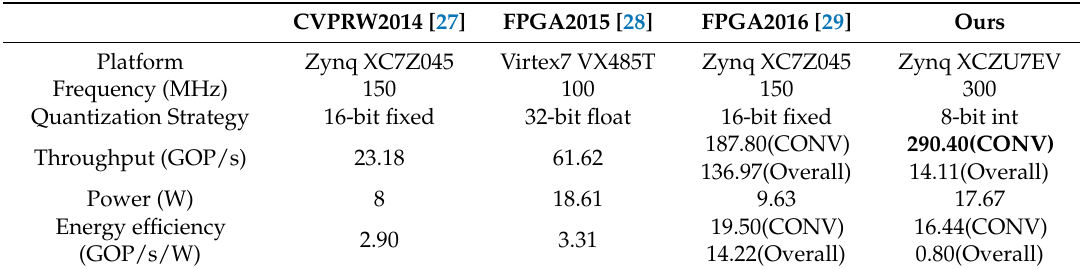
Table 8. Comparison to previous